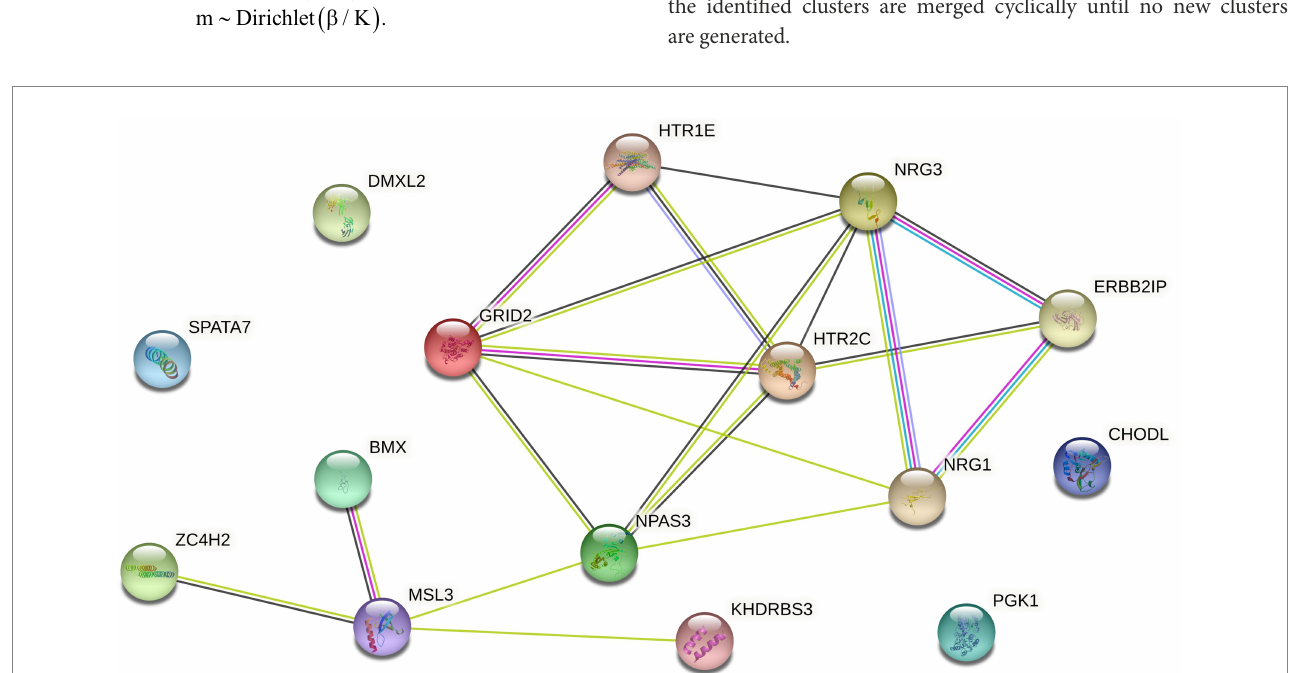
FIGURE 1 Interaction network of some genes in